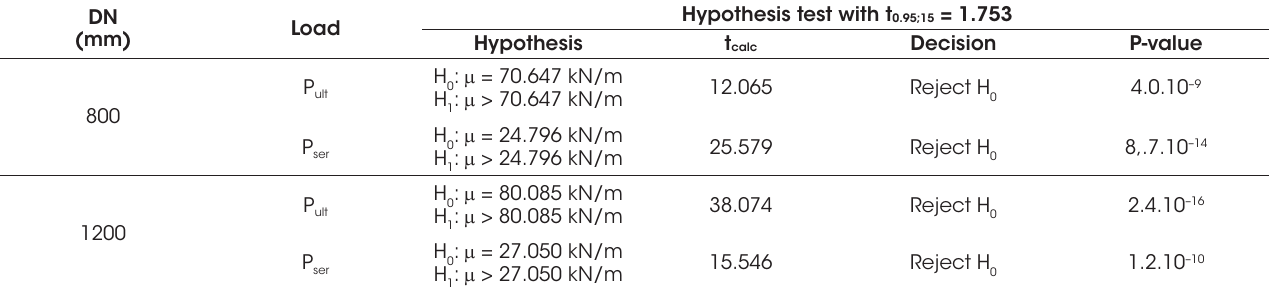
and P ( α = 5% and DV with characteristic values) ult ser